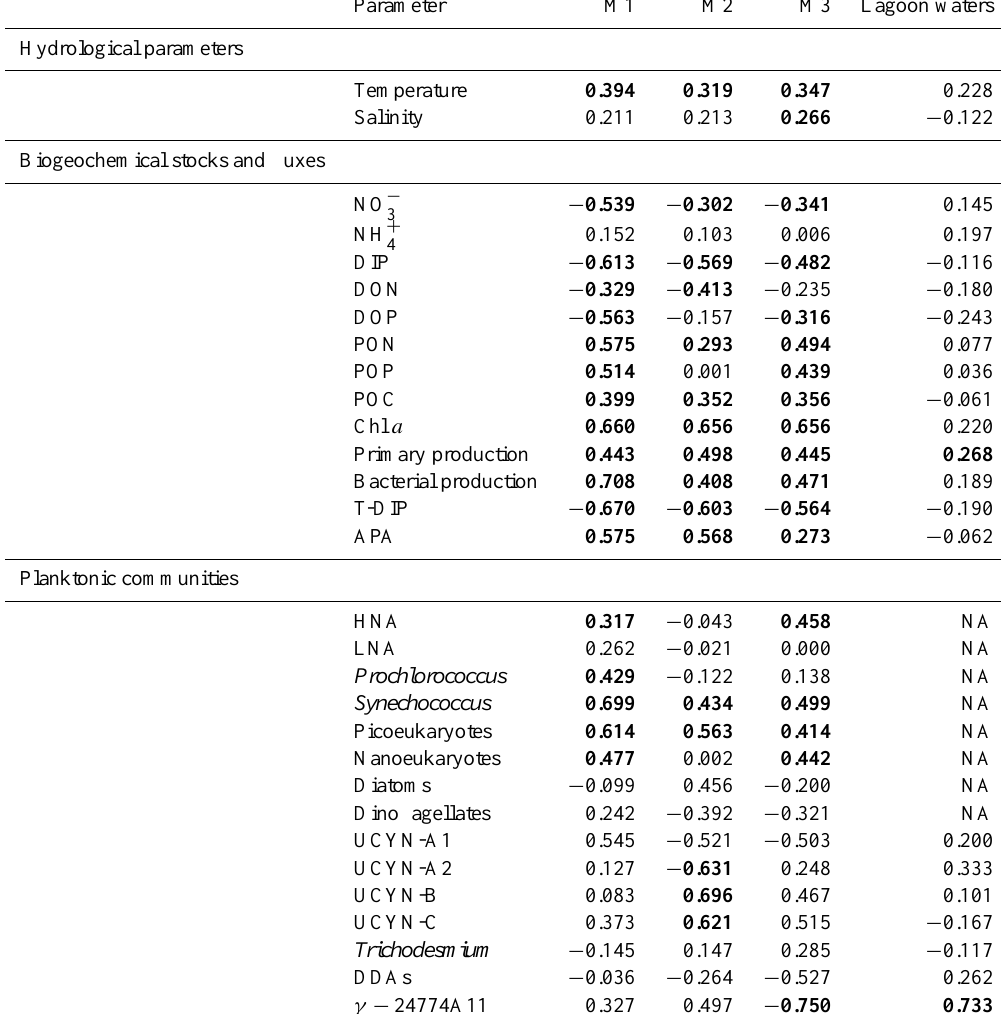
Table 2. Spearman correlation matrix of N 2 fixation rates and hydrological parameters, biogeochemical stocks and fluxes, and planktonic communities ( n = 66). The significant correlations ( p <0.05) are indicated in bold. NA – not